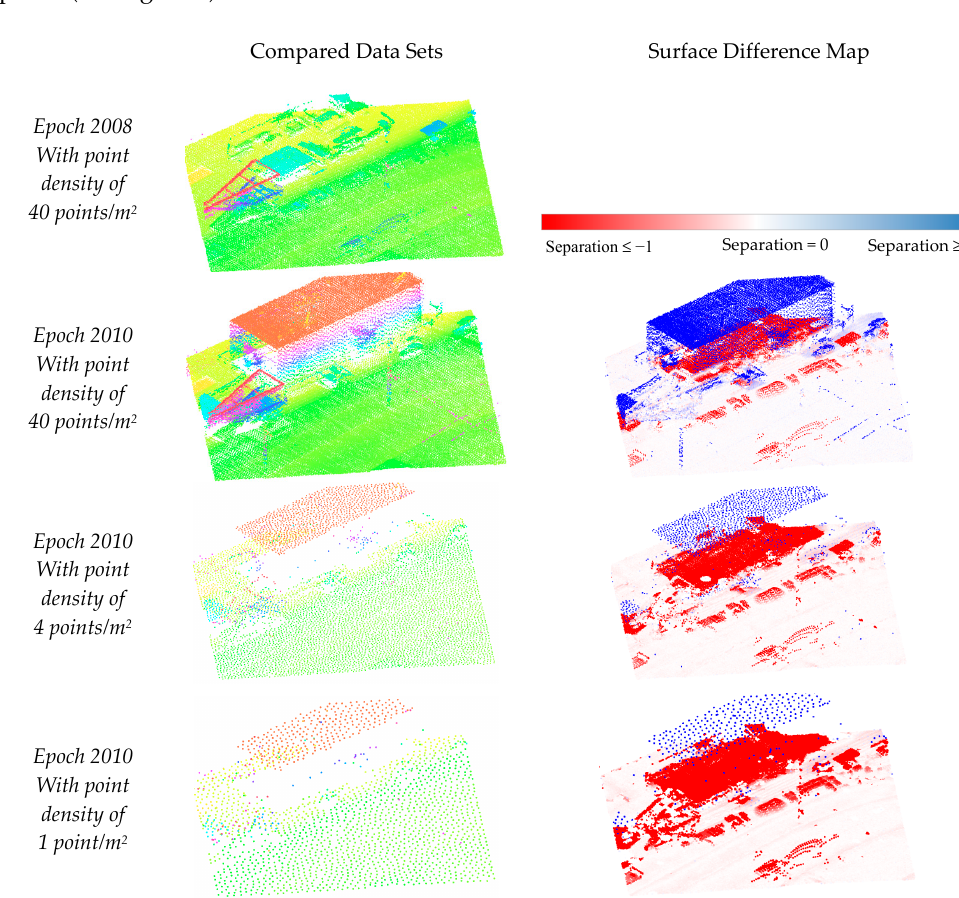
Figure 1. Examples of the surface difference map for various point densities. Comparison of data sets with different densities from the year 2010 with the data from the year 2008 showed that the locations of the changes are the same in all the difference maps. This indicates that the surface difference map generated with a neighborhood of 1.0 m points is suitable for all the data sets that have a point density larger than 1 point/m 2 .